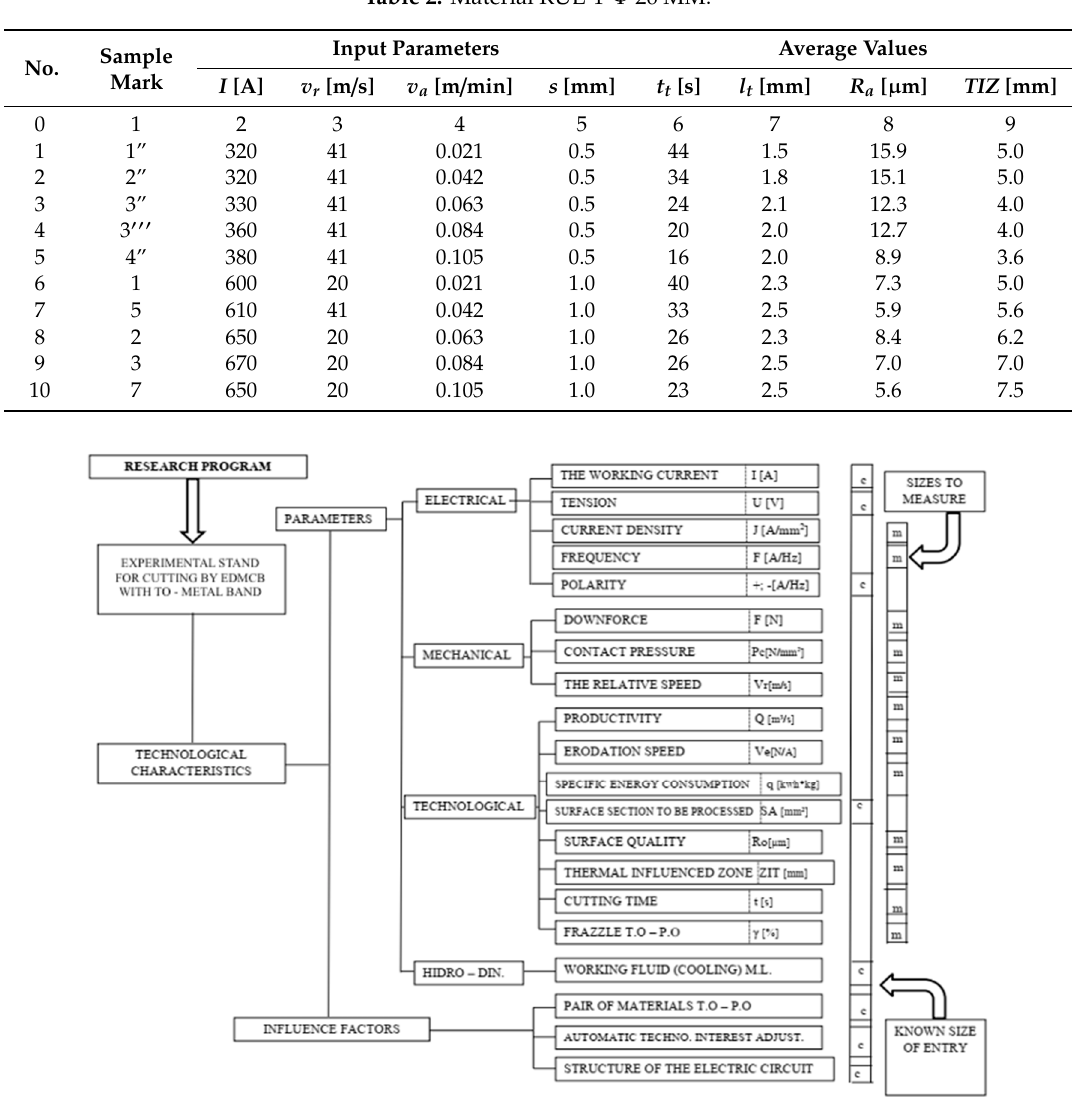
Table 2. Material RUL-1- Φ 26 MM.